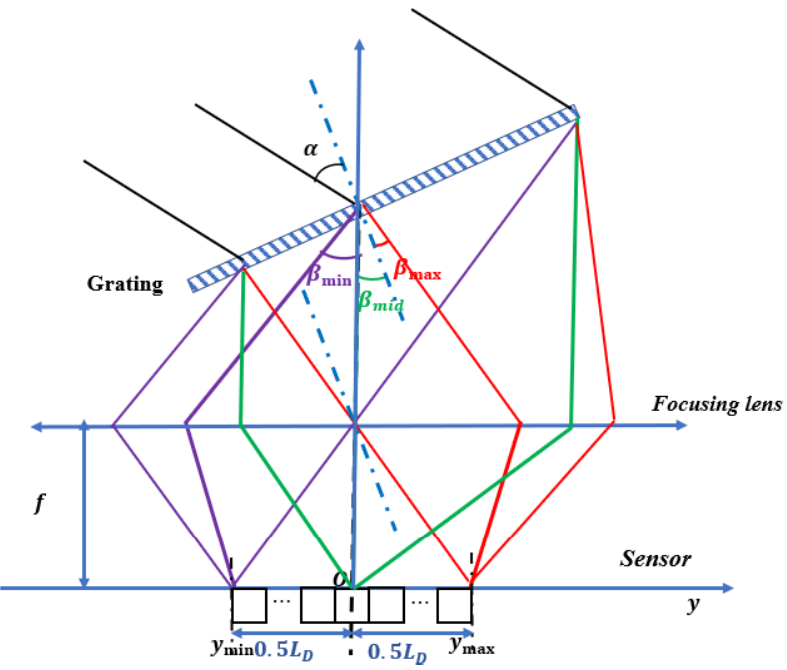
Figure 2. System equivalent optical path schematic.